Question: Express in one sentence what the figure is showing.
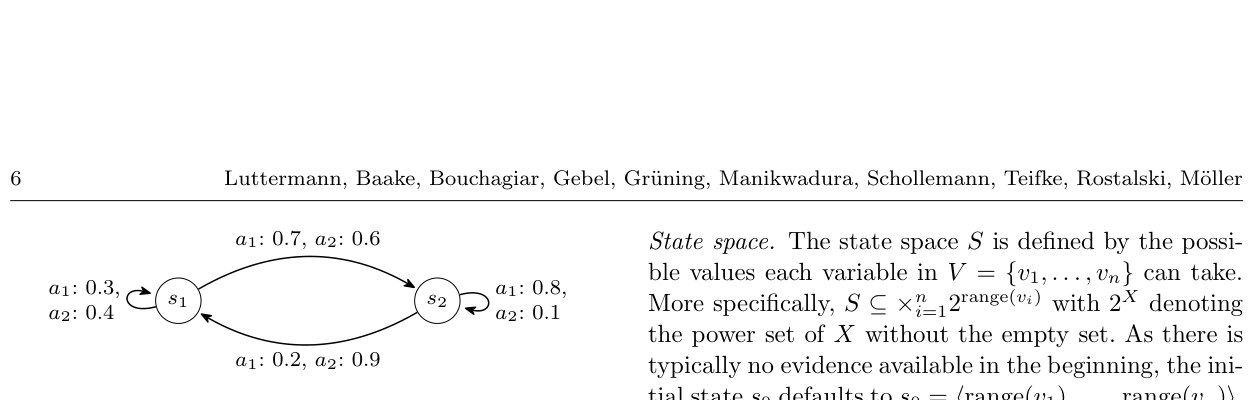
Answer: An example for an MDP with states S = {s1, s2} and actions A = {a1, a2}. The transition probabilities are given by the numbers written next to the edges. Rewards and the discount factor are omitted for brevity.